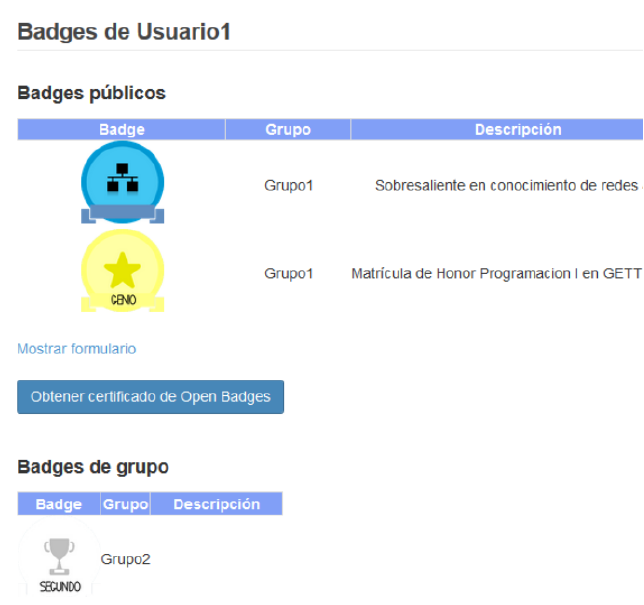
Figure 7. List of badges of an